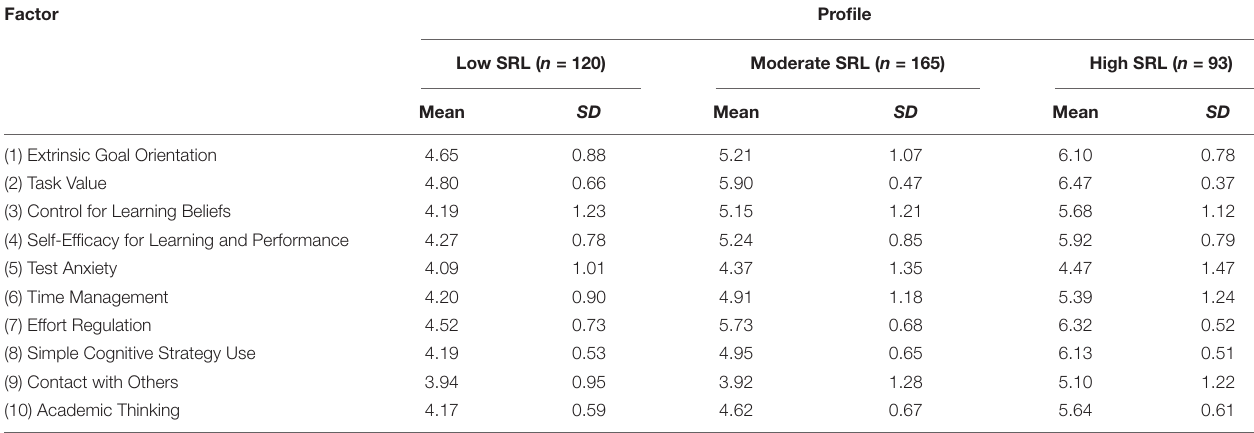
TABLE 5 | Factor mean scores across three latent